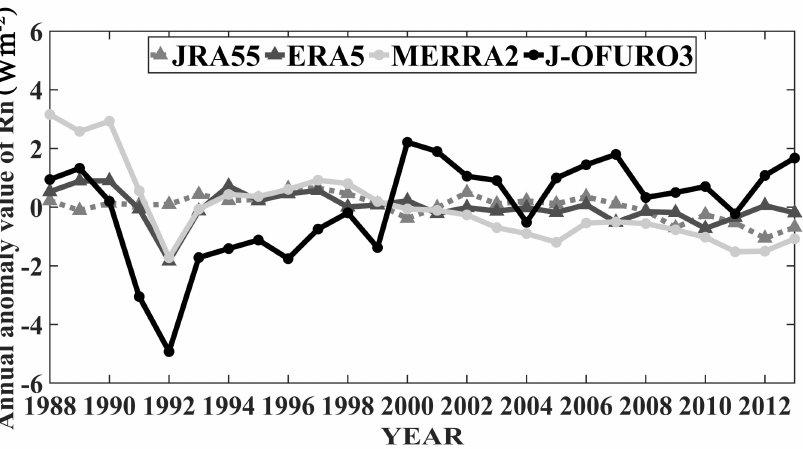
Figure 6. Interannual variations in the annual mean anomalies in the sea-surface R n values recorded from 1988 to 2013 in JRA55, ERA5, MERRA2, and